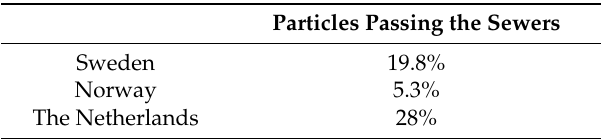
Table 14. The amount of microplastics, including tyre wear and tear, passing the